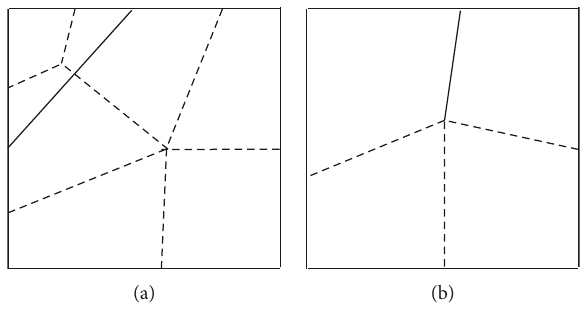
Figure 3: Element division for unconventional finite elements. (a) Subelements penetrated by crack. (b) Subelements with crack tip.